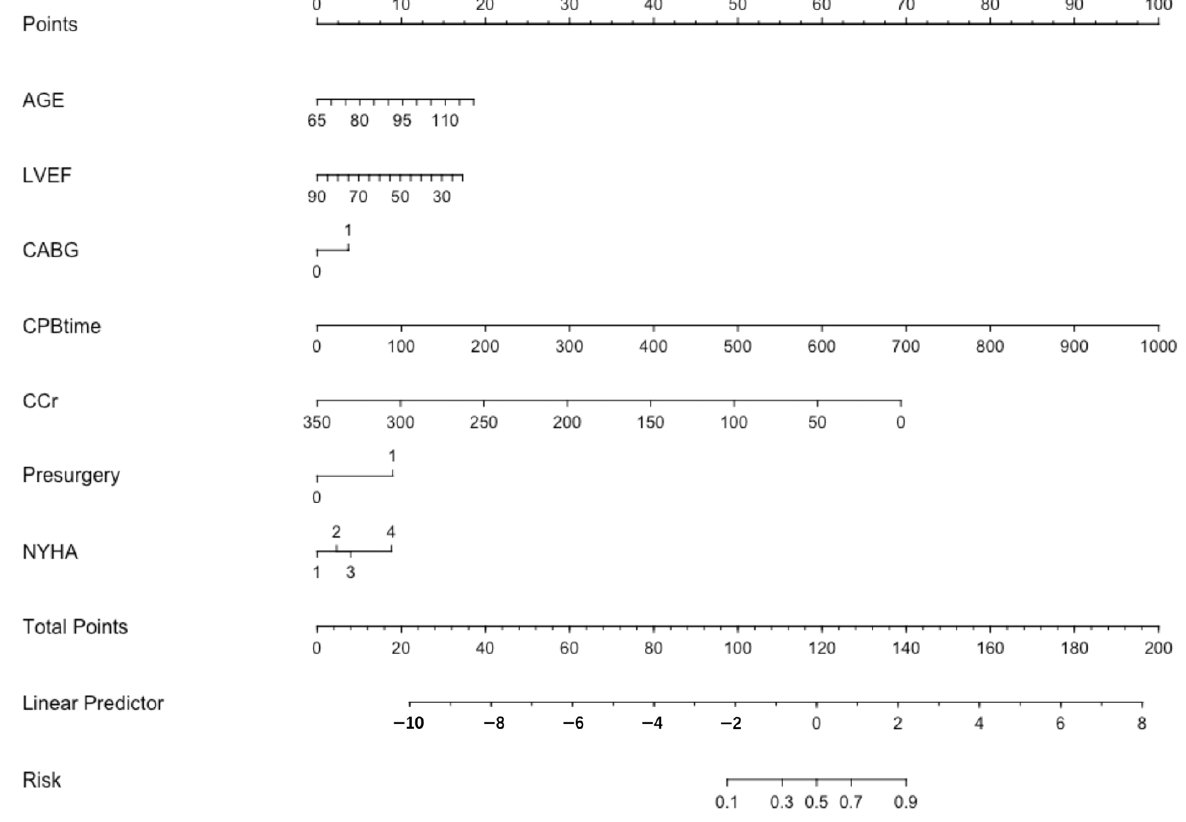
Figure 7. One example of nomogram. Enter the values of 7 key variables to predict the risk of in ‐ hospital mortality and show the contribution of each value to the outcome. 3.4. Establishment of ML Prediction Models In the training data, model establishments and internal validation were performed using the 10 folds cross validation method. The ROC is shown in Figures 8 and 9 and the Brier score is shown in Figure 10. The results showed that LDA, SVC and LR had the largest AUC and the lower Brier score, which suggests superior discrimination and calibration of other ML prediction models. In addition, we observed a larger AUC of the nomogram than other ML models and a similar Brier score to the LDA, SVC and LR models.